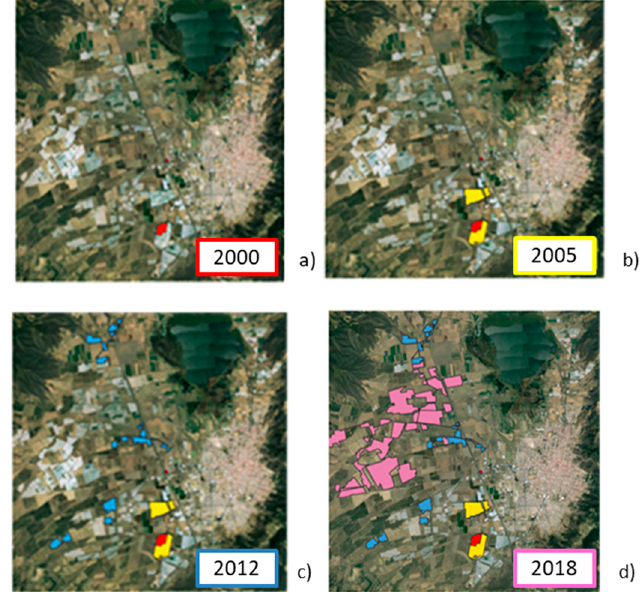
Figure 11. Greenhouse “time-lapse” of evolution in the 2000–2018 period ( a – d ). Time series of images with the Google Earth Time Slider tool provided by Google Earth Pro (v. 7.1.5.1557).